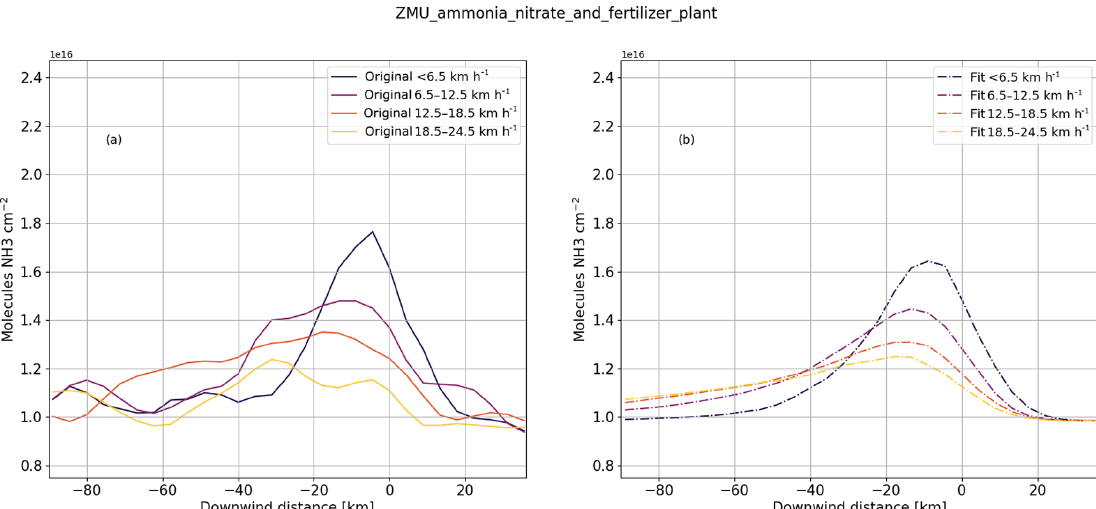
Figure 4. Mean total column cross sections of the original and reconstructed plume shape for the ZMU fertilizer plant in Kirovo-Chepetsk, Russia. Panel (a) shows the original CrIS NH 3 total column distribution (2013–2017) as a function of wind speed. The cross section is a cross-sectional average of the striped black square shown in Fig. 3. Panel (b) shows the mean cross section of the reconstructed plume. Table 1. Summary of factors of uncertainty in the final satellite emission estimates for IASI-A, -B and CrIS. Source of